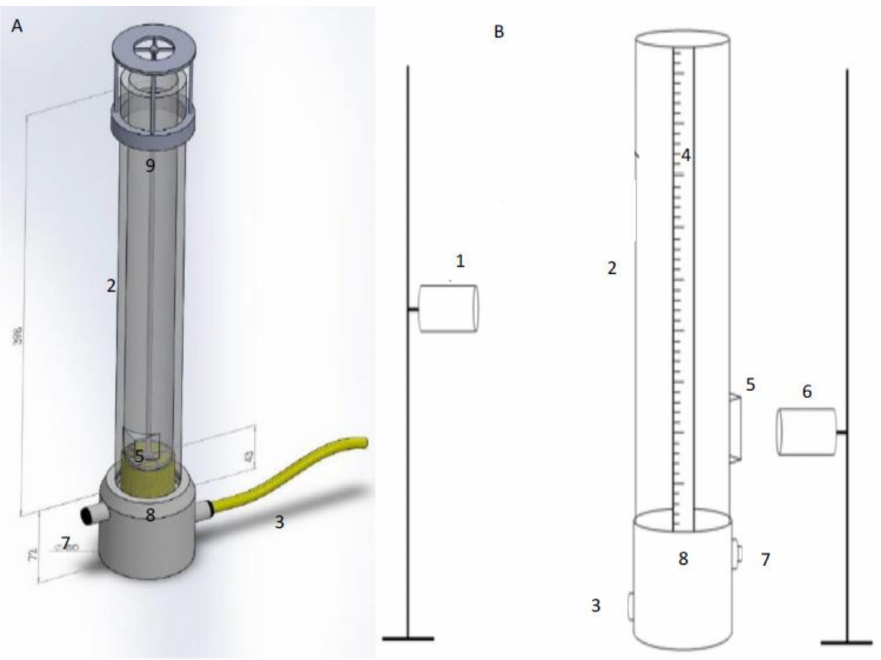
Figure 1. Drawing of the foam column used in the experiments. ( A ) shows a depiction of how the column will look when porous media is used instead of capillaries; a metal holder has to be present to prevent unwanted ejection of the media from the column, due to pressure build-up beneath the media. ( B ) shows a schematic of the experimental